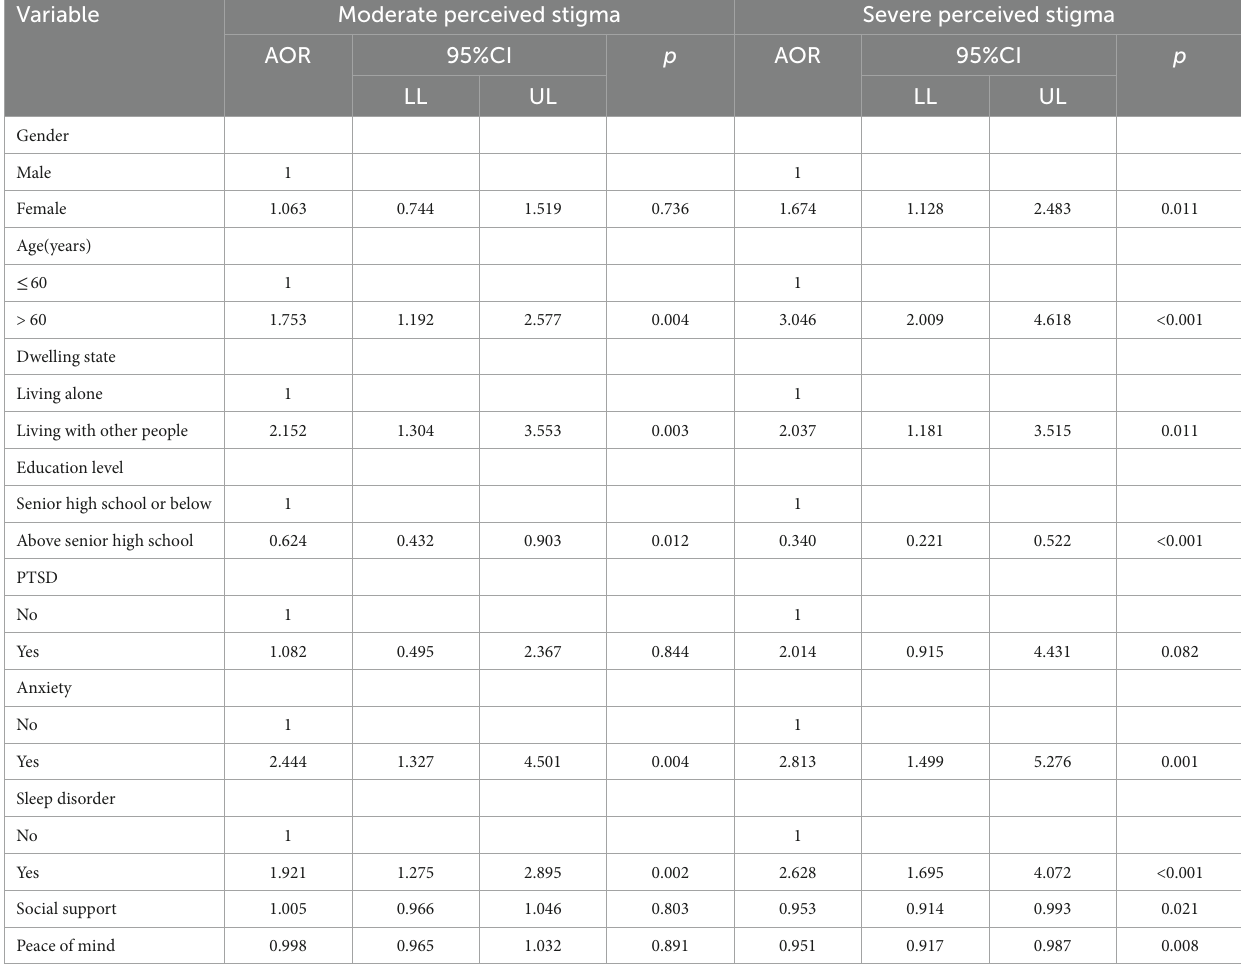
TABLE 7 Multinomial logistic regression analysis of influencing factors of perceived COVID-19 stigma of RD. Variable